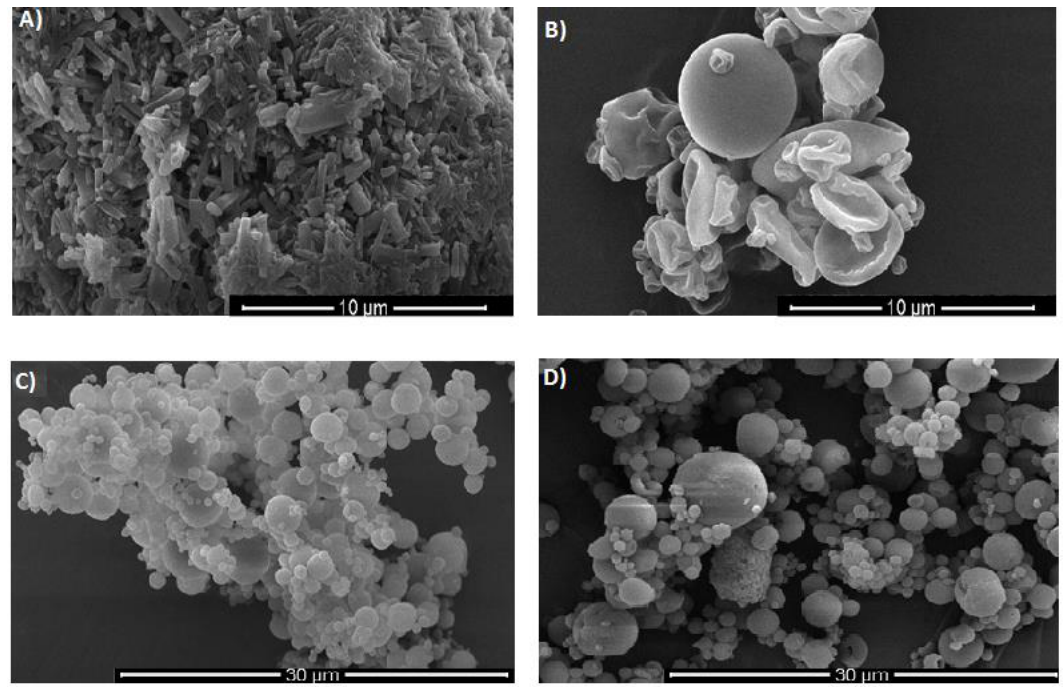
Figure 2. SEM pictures of ( A ) EC in powder form; ( B ) spray-dried ethanolic solution of EC